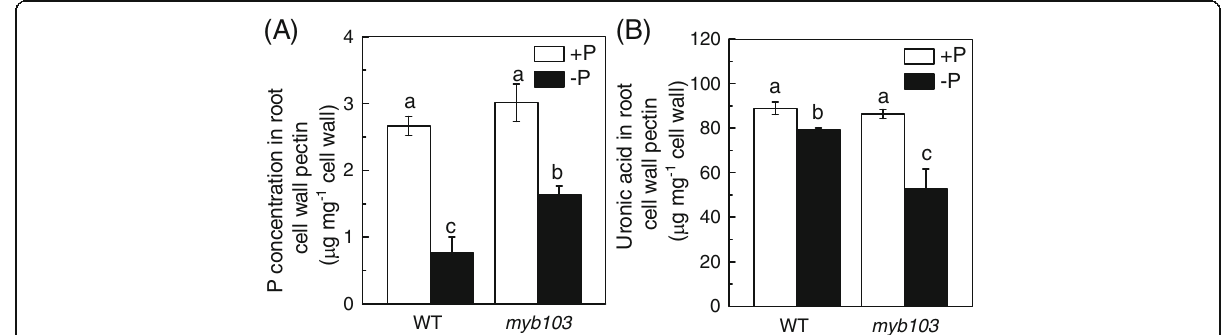
Fig. 6 P concentration in cell wall pectin and pectin content. Seedlings were hydroponically treated with +P or -P solution for 7 d, and cell wall materials extracted from roots were fractionated into pectin, then the P concentration ( a ) and the uronic acid level ( b ) in the pectin were measured. Values are means ± SD, n = 4. Different letters on the bars indicate significant differences at p < 0.05